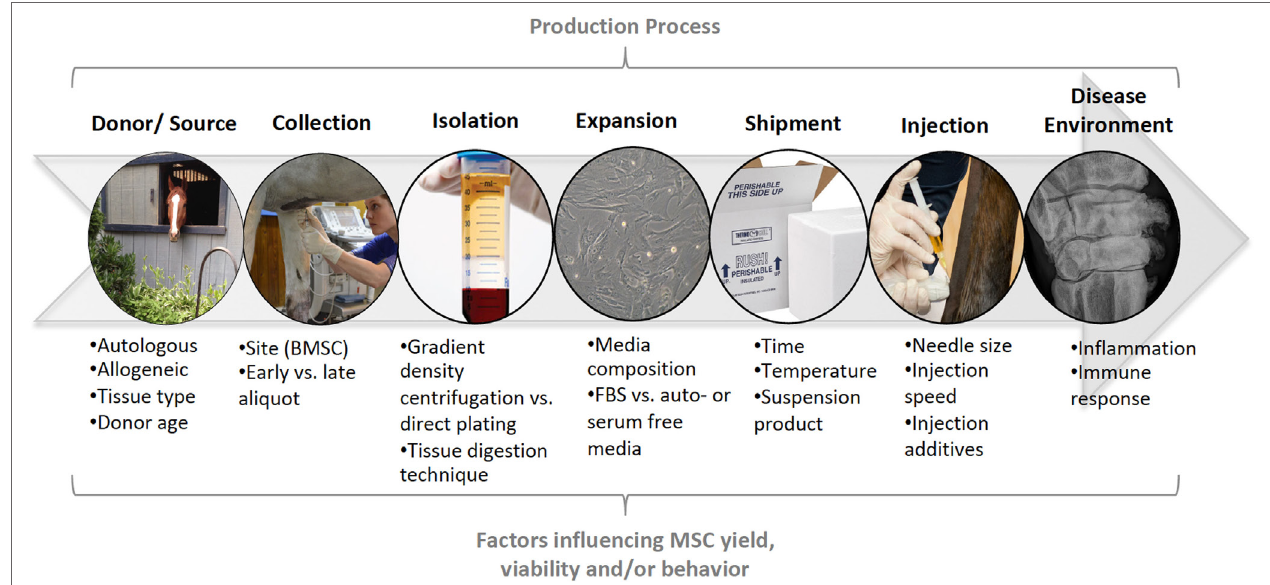
FiGURe 1 | Summary of the production process for mesenchymal stem cells (MSCs). At each stage in the production process (top), specific factors may influence the yield, viability, and/or behavior of MSCs in veterinary patients. These factors need to be considered during clinical use of MSCs and controlled for, or described, in preclinical and clinical